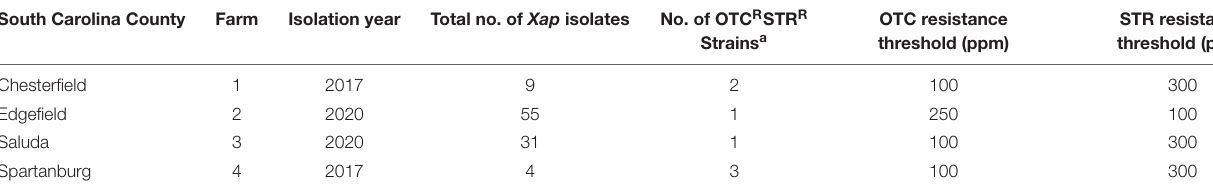
TABLE 2 | Oxytetracycline- (OTC) and streptomycin (STR)-resistant Xanthomonas arboricola pv. pruni ( Xap ) strains used in this study. South Carolina County Farm Isolation year Total no. of Xap isolates No. of OTC R STR R